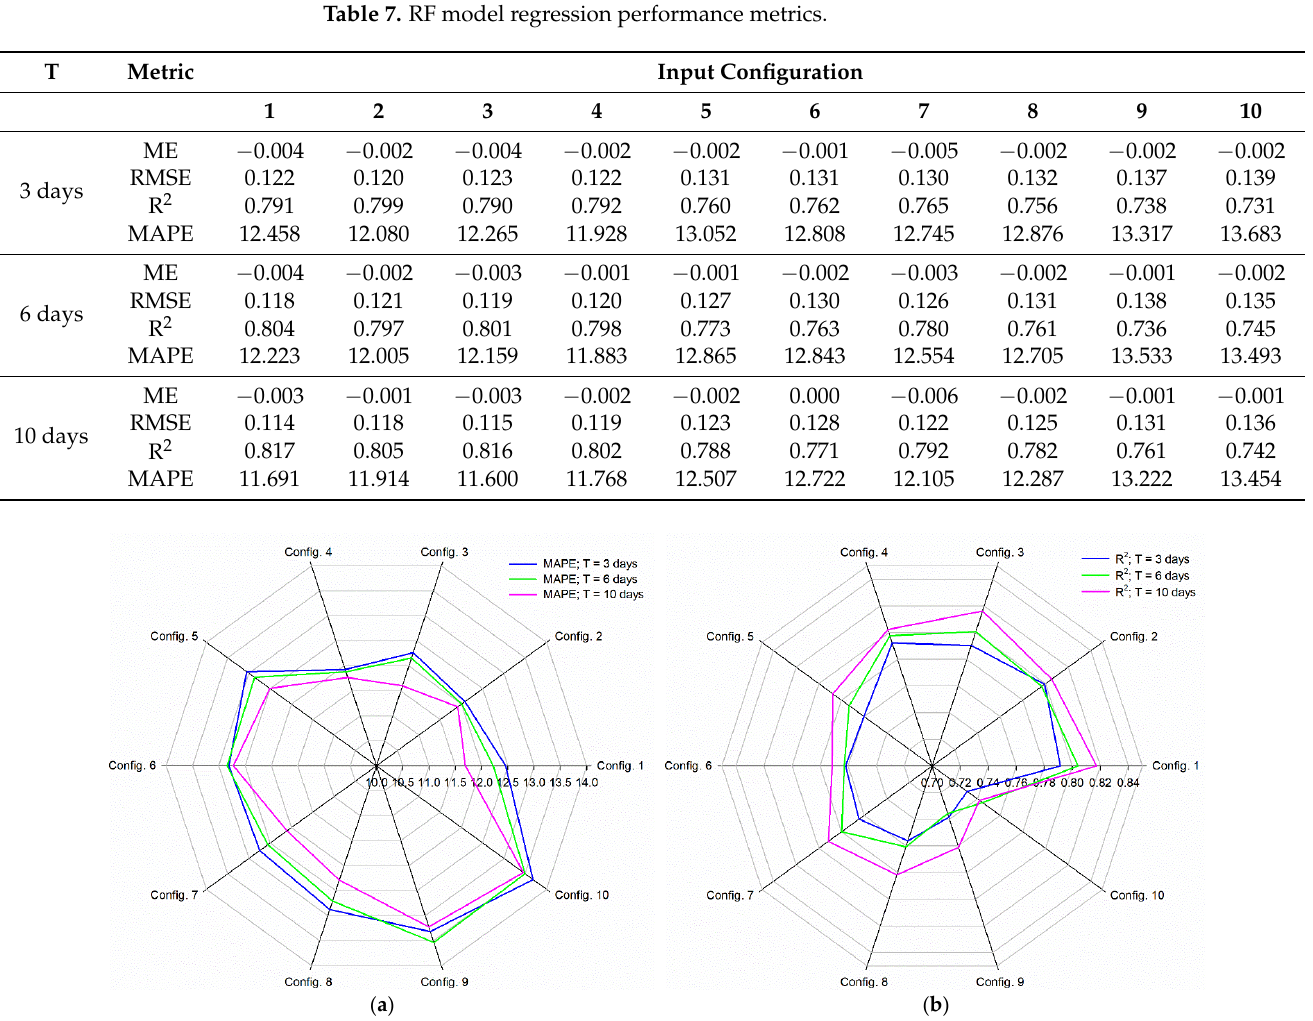
Figure 3. MAPE ( a ) and R 2 ( b ) regression metrics obtained with RF with the different input configurations for T = 3, 6 and 10 days. A coefficient of determination (R 2 ) of up to 0.817 was obtained with Configuration 1 and T = 10 days. Intrigliolo and Castel [16] obtained an R 2 of 0.62 when correlating Ψ m and